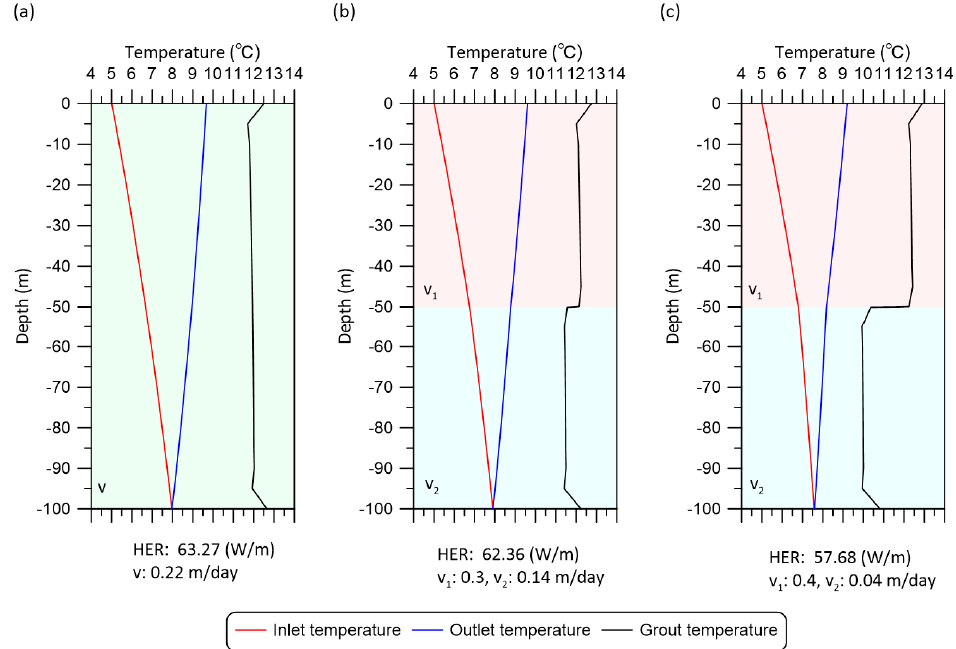
Figure 5. Temperature distribution in the borehole and result of GHE simulation. Groundwater flow velocity was set as ( a ) v : 0.22 m/day, ( b ) v 1 : 0.3 m/day and v 2 : 0.14 m/day, and ( c ) v 1 : 0.4 m/day and v 2 : 0.04 m/day. Energies 2019 , 12 , x FOR PEER REVIEW 8 of 21